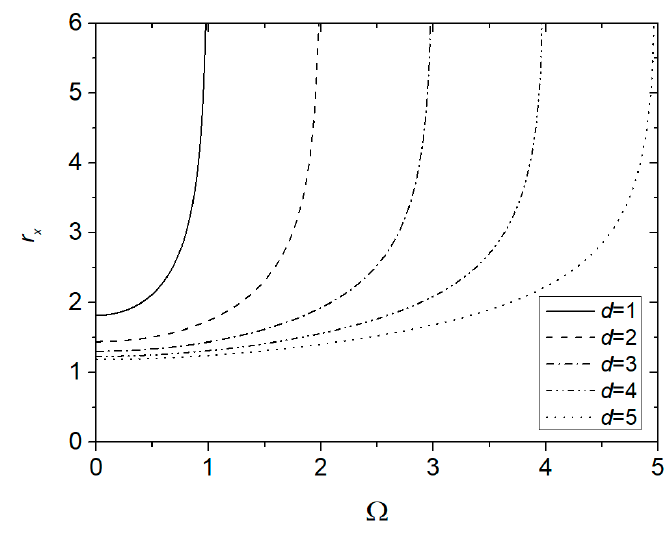
8 of 13 Figure 5. Dimensionless flow rate per unit width 𝑞 (cid:3051)(cid:3005) versus dimensionless pressure gradient Ω for different values of the distribution parameter 𝑑 . The hydraulic aperture for the parallel arrangement 𝑏 (cid:3009)(cid:3051) is obtained by solving the following implicit equation in the unknown 𝑟 (cid:3051) : 𝑟 (cid:3051) cosh(𝑟 (cid:3051) Ω) − 1 Ω sinh(𝑟 (cid:3051) Ω) = 1 2Ω (cid:4680)(𝑑 + 1)𝑢 − 1 (1 − 𝑢) (cid:3031)(cid:2878)(cid:2869) + (𝑑 + 1)𝑢 + 1 (1 + 𝑢) (cid:3031)(cid:2878)(cid:2869) (cid:4681) ; 𝑟 (cid:3051) = 𝑏 (cid:3009)(cid:3051) 〈𝑏〉.